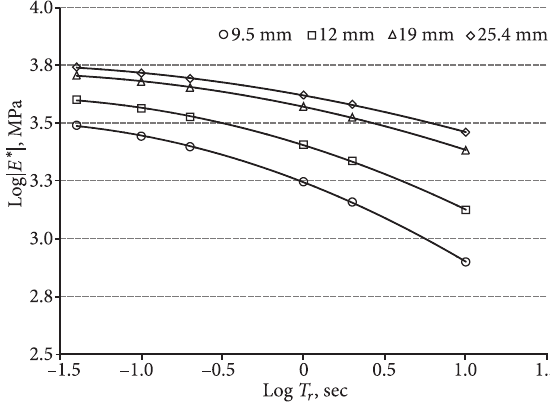
Fig. 5. Summary of slope coefficient for SMA mixtures